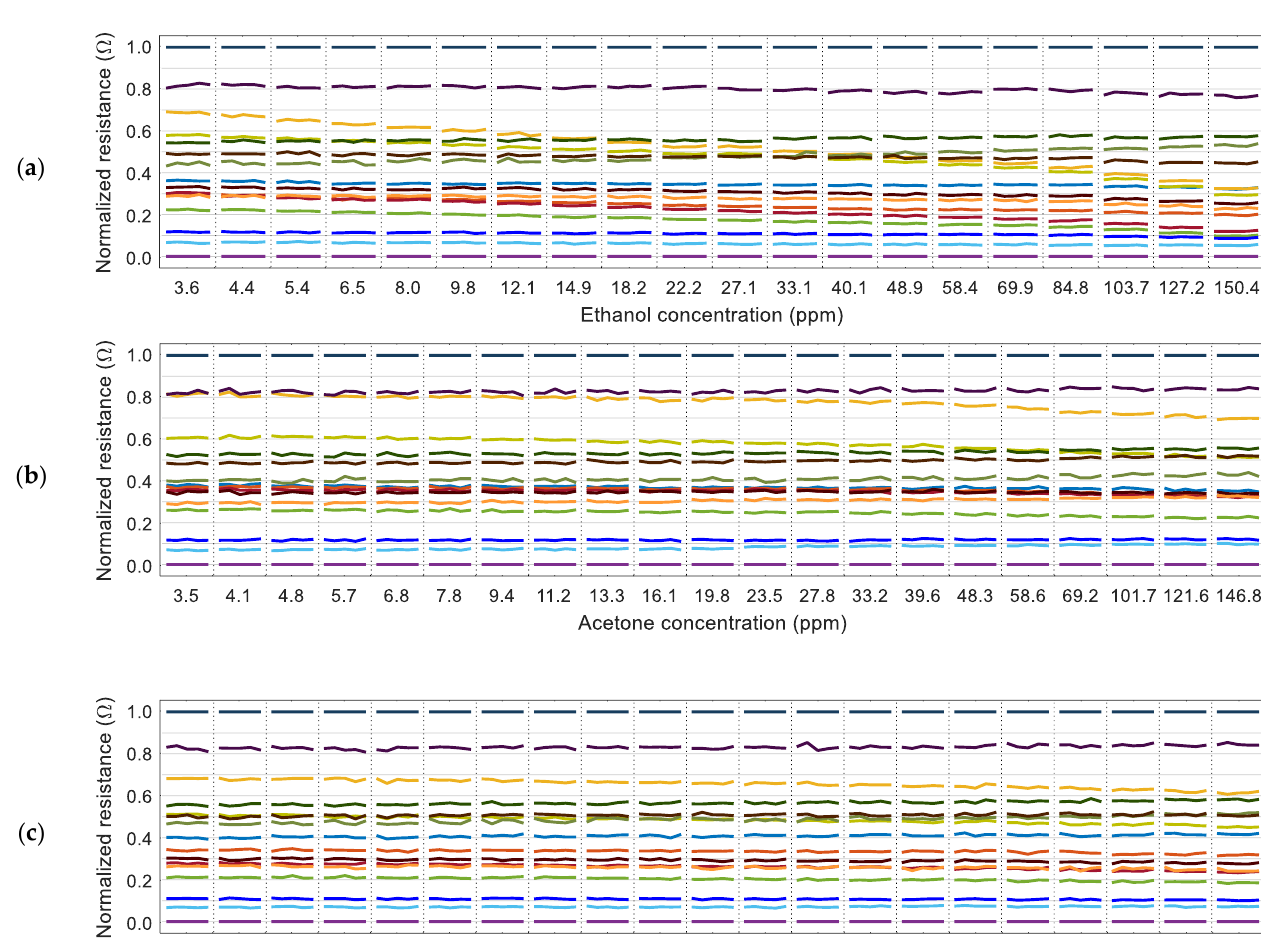
Figure 5. Representation of the normalized resistance of the sensing layer of the 16 MOX gas sensors (labeled with different colors) presented in Figures 3 and 4, relative to the gas concentration measured with the PID: ( a ) calibration with ethanol and ( b ) calibration with acetone. The alternative case ( c ) depicts the normalized resistance obtained in 21 consecutive measurements with air (without